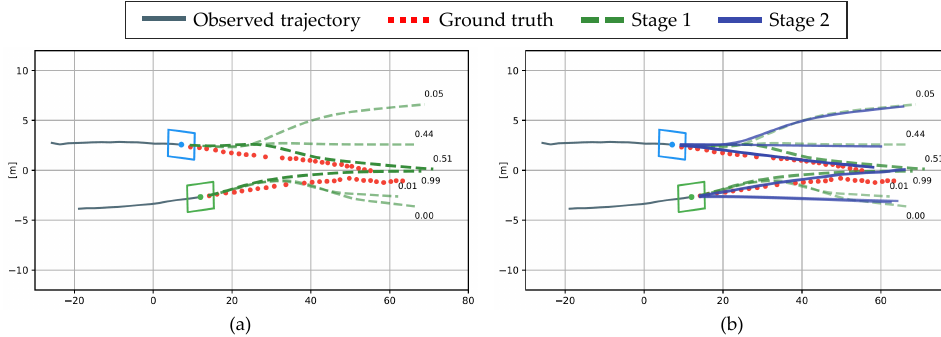
Figure 9. Qualitative evaluation of the proposed hierarchical method using real driving data: ( a ) Tra- jectory prediction in Stage 1; ( b ) Trajectory prediction in Stage